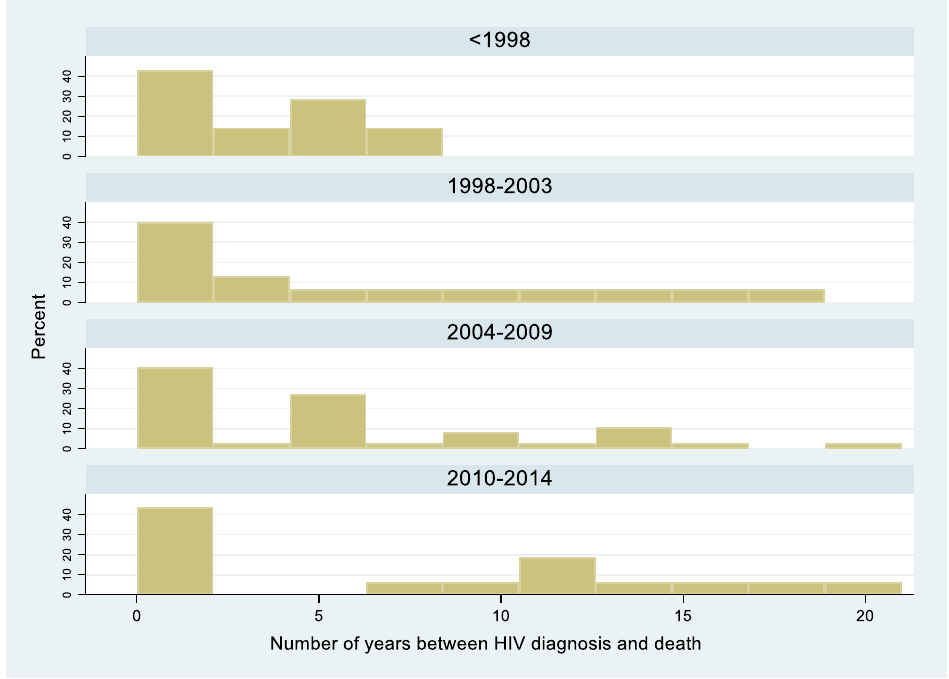
Figure 2. HIV-associated disseminated histoplasmosis: number of years between HIV diagnosis and death of any cause. 1981–2014, French Guiana.